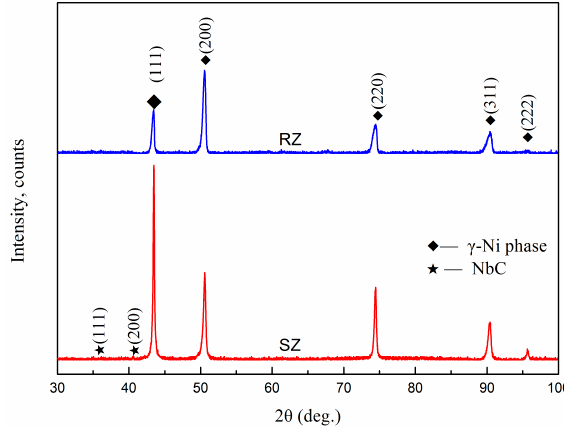
Figure 7. XRD patterns of SZ and RZ in the LARed samples.